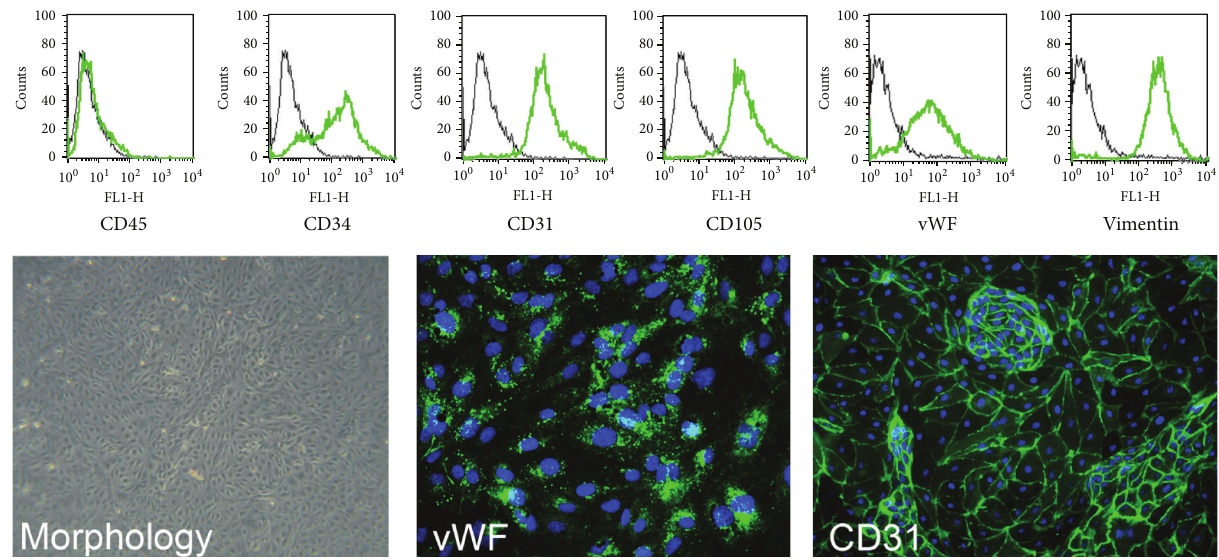
Figure 3: Characterization of the purity of endothelial cells isolated from endometriotic tissue. (A) EECs were characterized by cytofluorimetric analysis for the expression of CD45, CD34, CD31, CD105, vWF, and vimentin, and the expression of these markers (green lines)wascomparedwithcorrelatedcontrolantibodies(blacklines).TheexpressionofvWFandCD31wasconfirmedbyimmunofluorescence, on EECs grown to confluence in 8-chamber culture slides. After fixation and permeabilization the cells were stained with mAb anti-human CD31 or anti-vWF. The binding of mouse monoclonal antibodies was revealed by the incubation with goat anti-mouse IgG FITC-conjugated secondary antibodies. Nuclei were stained in blue by DAPI: original magnification 200x.